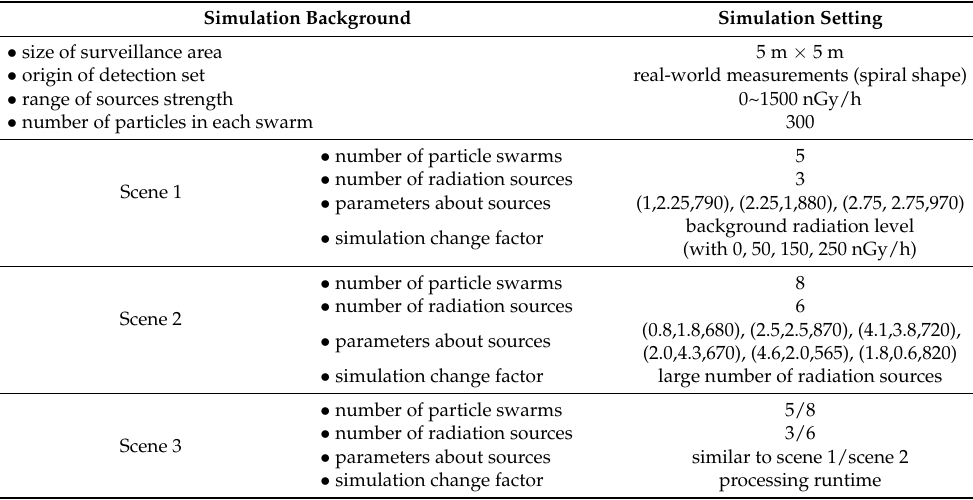
Table 1. The simulation settings with different